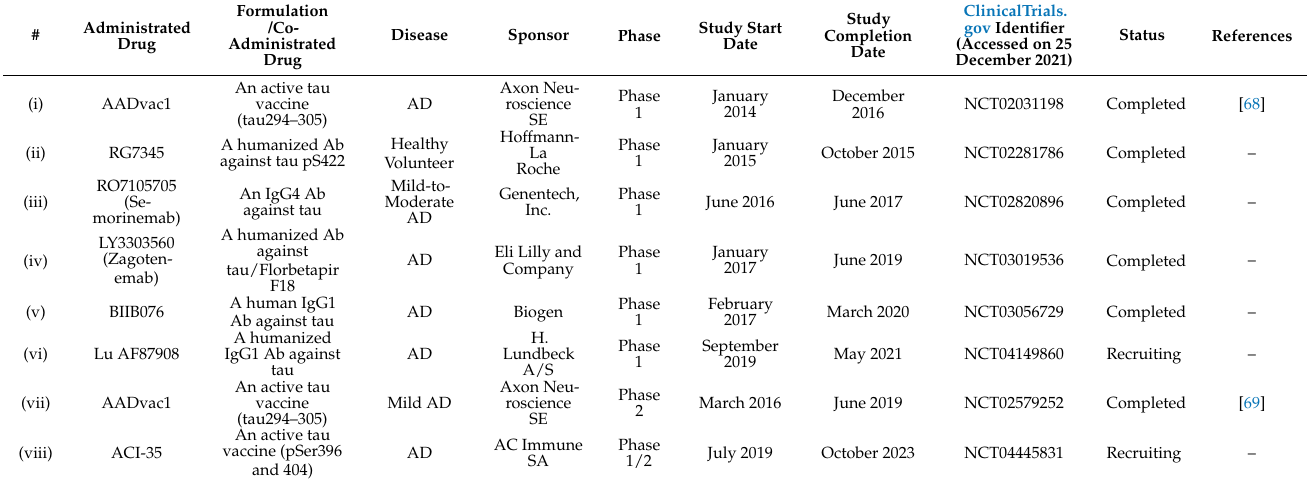
Table 1. Summary of clinical trials focusing on anti-tau Abs described in this